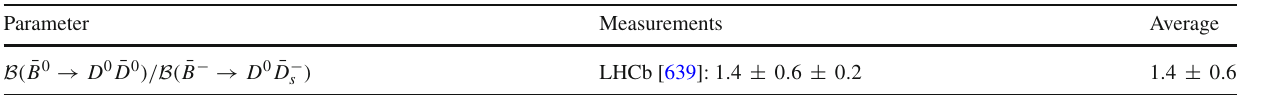
Table 112 Relative decay rates [ 10 − 3 ] Parameter Measurements